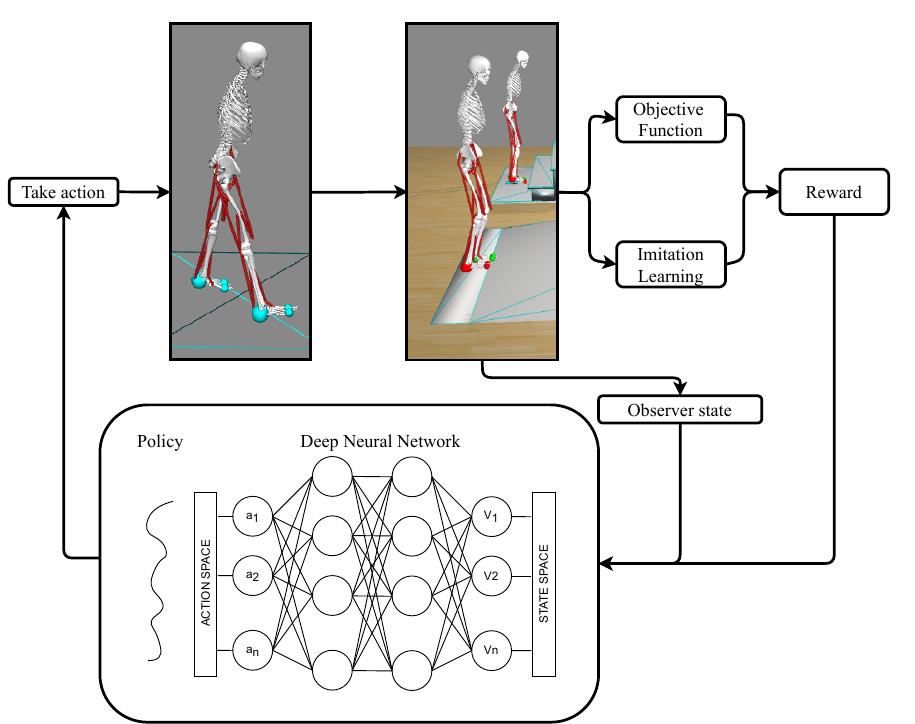
Figure 1. The proposed DRL method for the dynamic optimization of the forward dynamics of a human musculoskeletal model during stairs or ramp